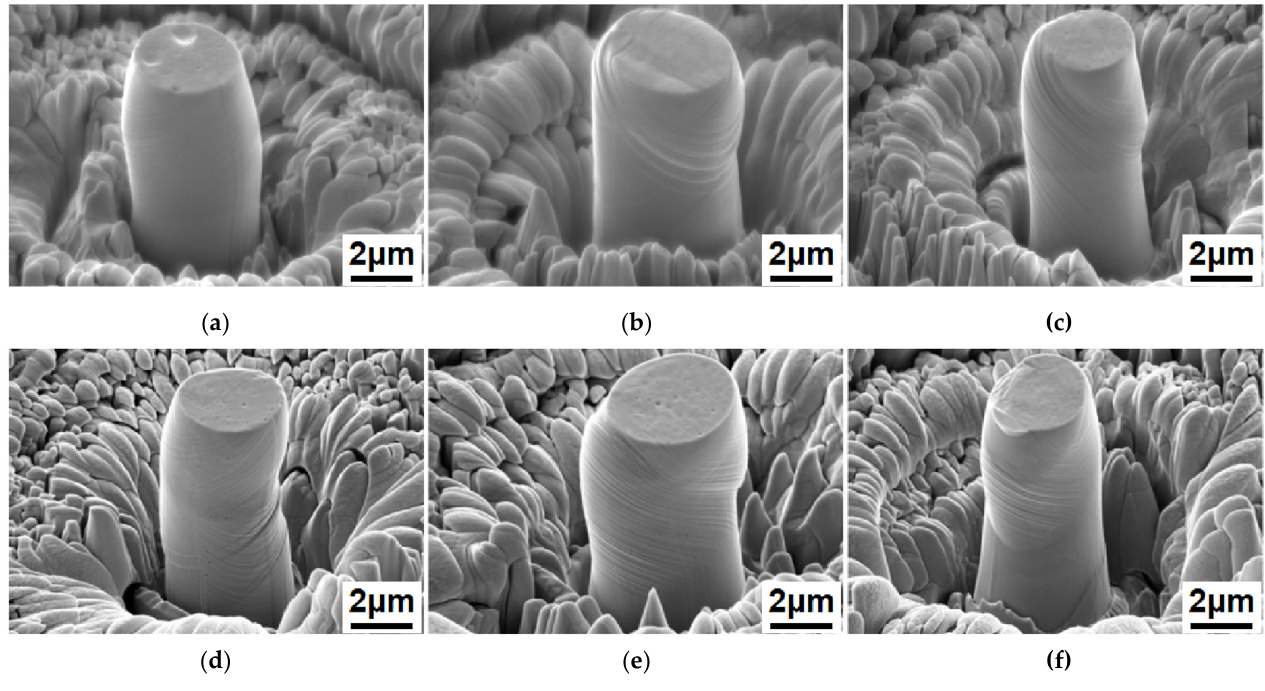
Figure 12. SEM morphology of SLM HEA FIB cone structure after in situ quasi-static compression: ( a – c ) FIB sampling section is perpendicular to the BD and ( d – f ) the FIB sampling section is parallel to the BD.